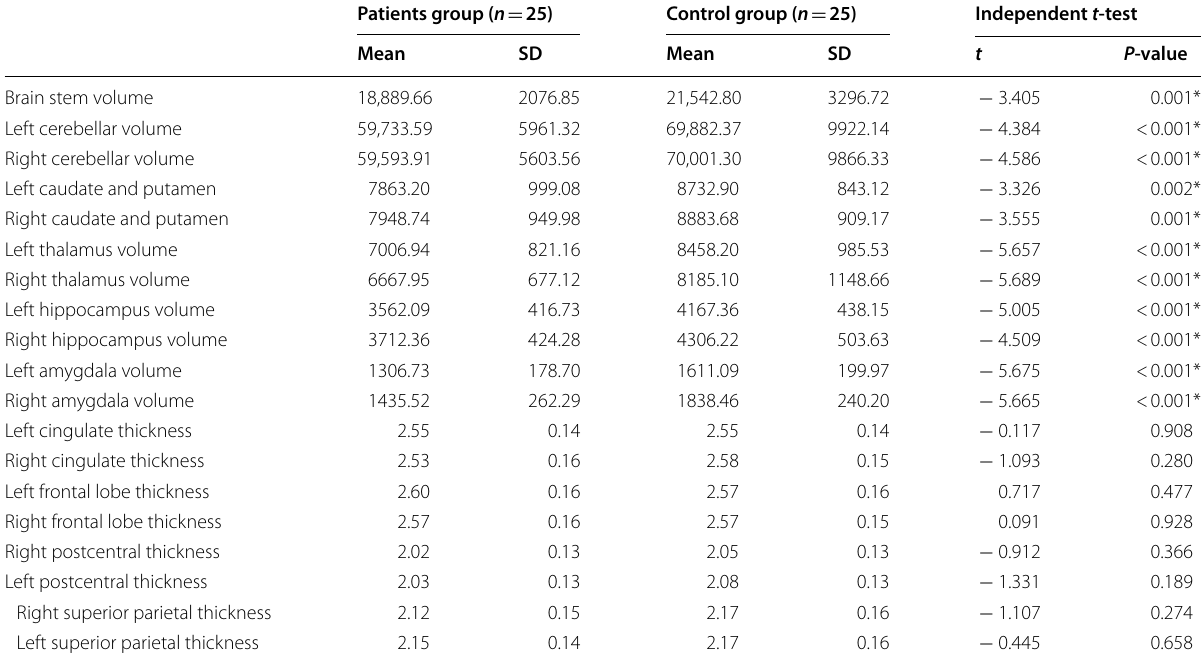
Table 3 Comparison between patients and control groups as regards segmental brain volumetry (mm 3 ) and thickness (mm) parameters